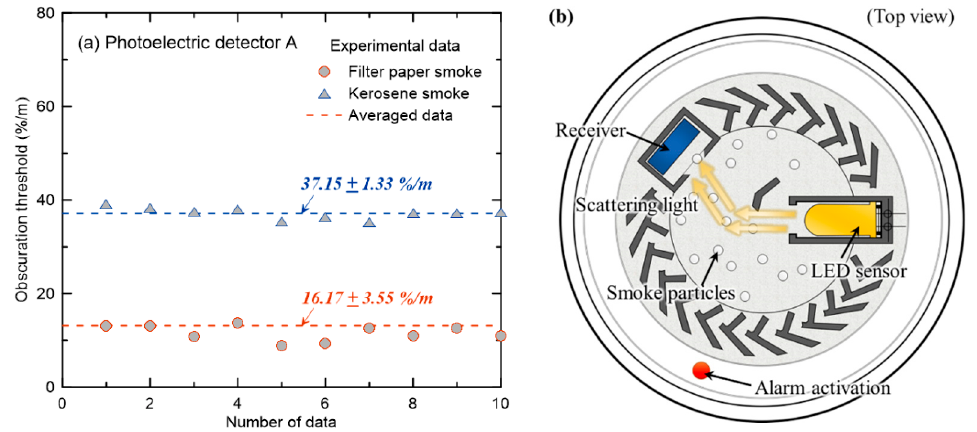
Figure 7. For the photoelectric smoke detector, ( a ) obscuration thresholds with filter paper and kerosene and ( b ) the conceptual diagram of the detector.